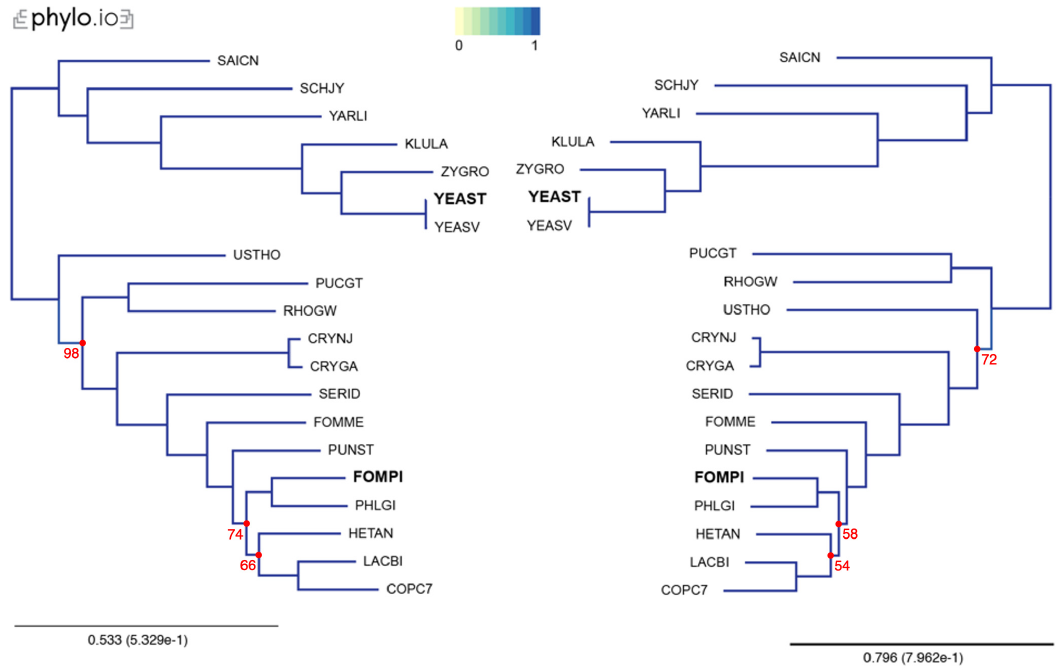
Figure 4. Comparison of phylogenetic trees, using additional species, computed by IQ-TREE, under a LG substitution model (left), and RAxML, under a LG substitution model, a discrete Gamma model of rate heterogeneity with 8 categories and empirical amino-acid frequencies (right). Trees were computed with 18 yeast species present in OMA, plus two additional proteomes (YEAST and FOMPI). The leaves of the trees are the UniProt 5-letter species codes. Genes used to compute the tree had to be shared by at least 90% of the species (minimum species coverage: 0.9, maximum number markers: -1). This represents 880 OGs. Visualization was done with phylo.io; different shades of blue show variations in topology (in this case both trees have identical topology). Bootstrap values are reported in red for each bipartition with a bootstrap